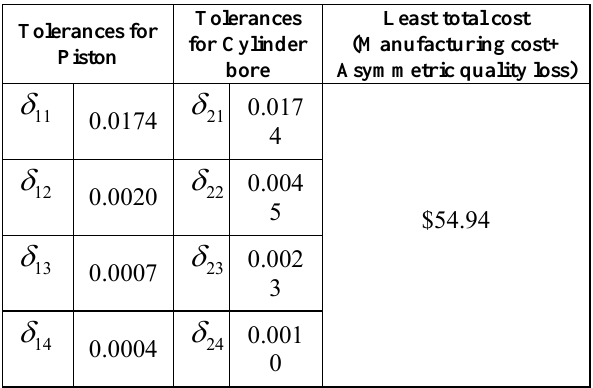
Table 3 Optimal tolerances allocated using